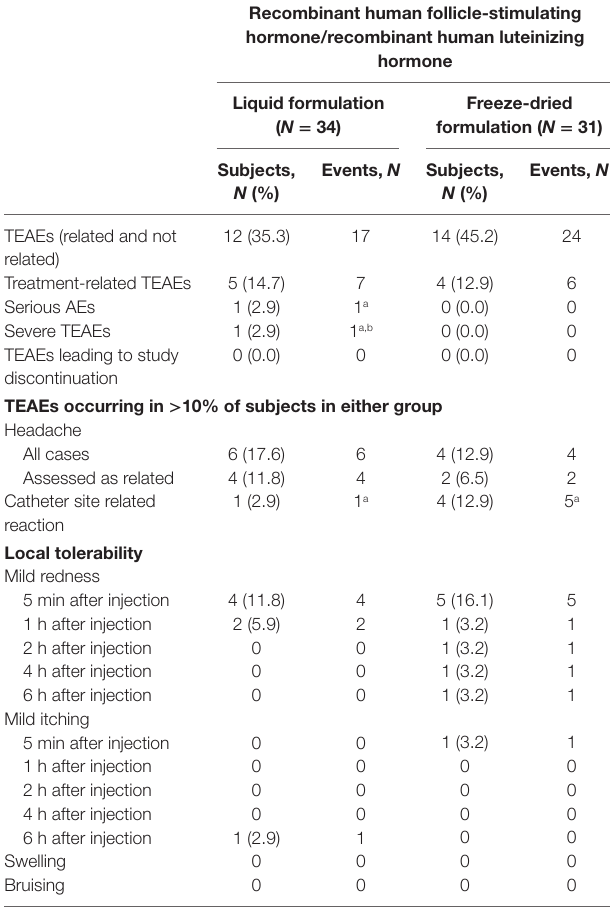
TaBlE 4 | Comparison of treatment-emergent adverse events after receiving the liquid or freeze-dried formulations of recombinant human follicle-stimulating hormone/recombinant human luteinizing